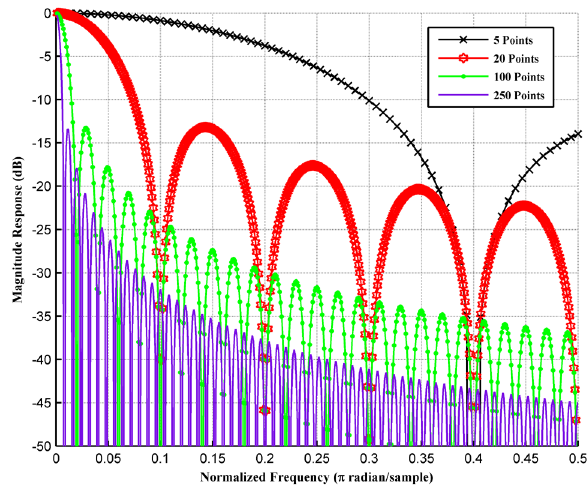
Figure 3: Frequency responses of 5, 20,100 and 250 points average filters are shown by black plus, red star, green circle and purple solid lines,